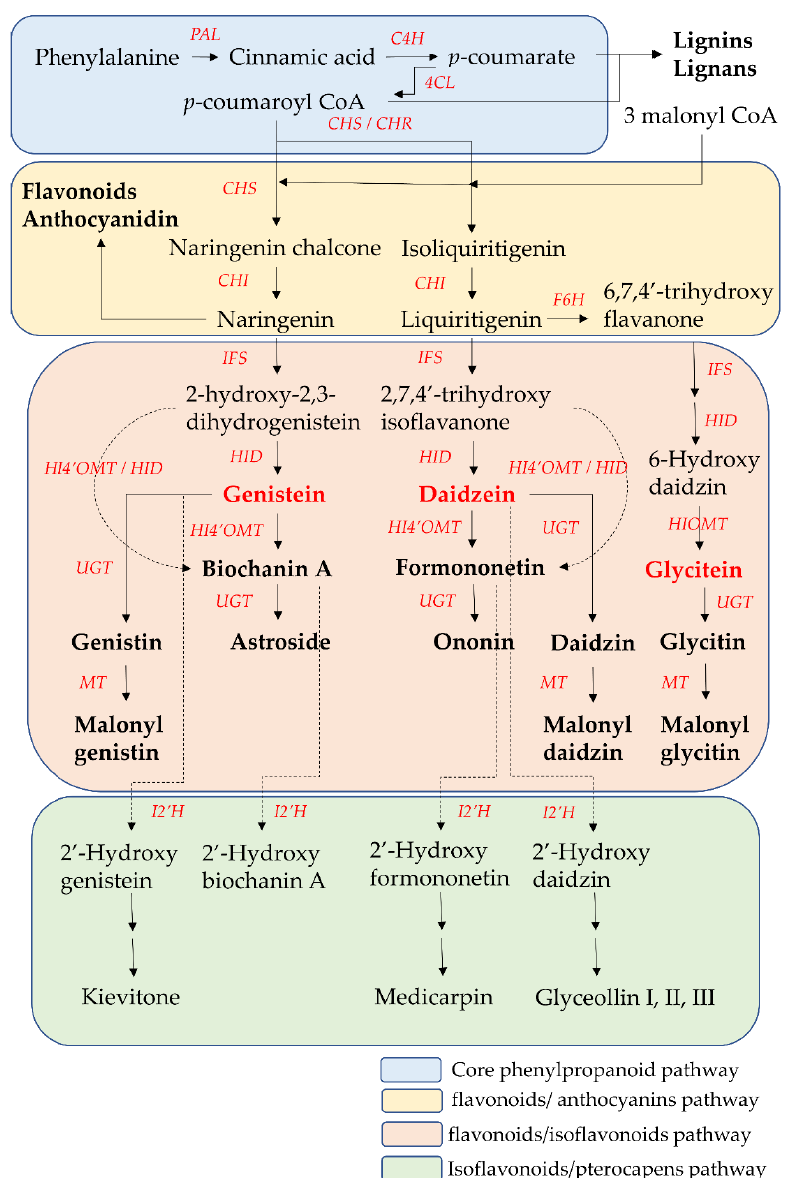
Figure 3. The core phenylpropanoid pathway and isoflavones biosynthesis pathway. 4CL, 4-coumarate CoA-ligase; C4H, cinnamate 4-hydroxylase; CHI, chalcone isomerase; CHR, chalcone reductase; CHS, chalcone synthase; F6H, flavonoid 6-hydroxylase; HI4 (cid:48) OMT, hydroxyisoflavanone 4 (cid:48) -specific O-methyltransferase; HID, 2-hydroxyisoflavanone dehydratase; HIOMT, hydroxyisofla- vanone O-methyltransferase; I2 (cid:48) H, isoflavone 2 (cid:48) hydroxylase; IFS, isoflavone synthase; MT, malonyl- transferases; PAL, phenylalanine ammonia-lyase. UGTs.